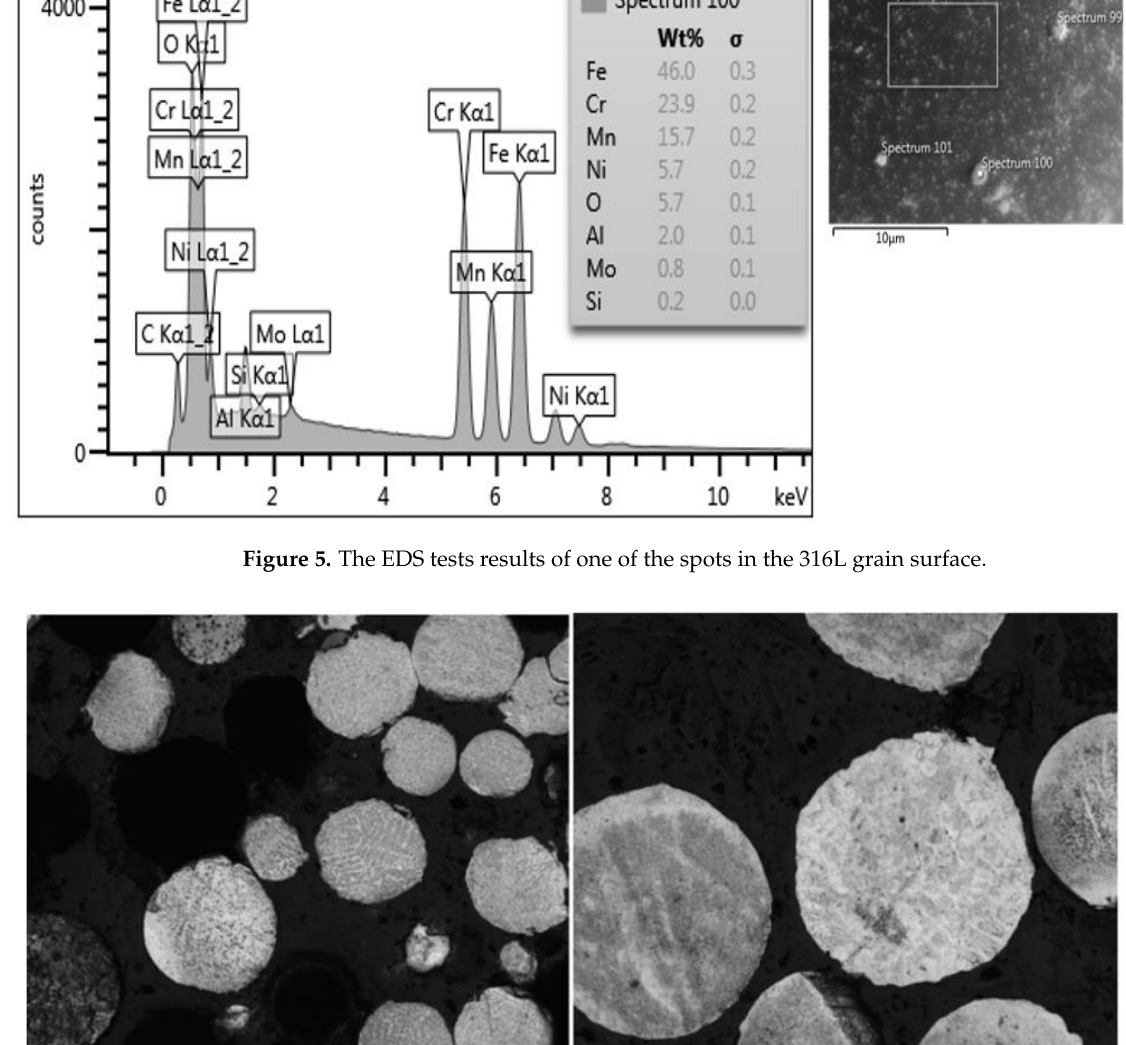
Materials 2022 , 15 , x FOR PEER REVIEW